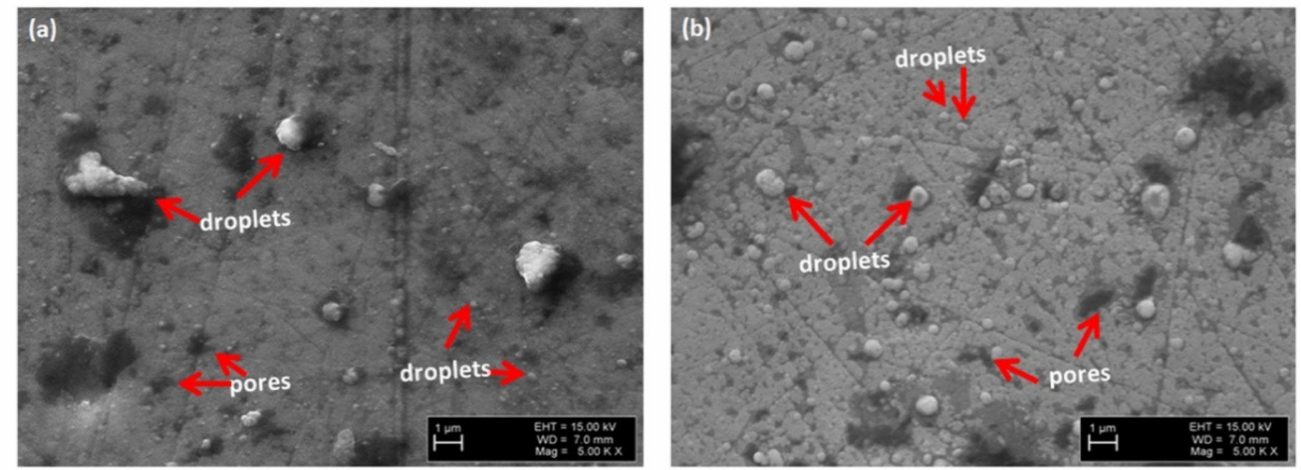
Figure 1. SEM images of the pristine surface of ( a ) ta-C and ( b ) Al 2 O 3 /ta-C